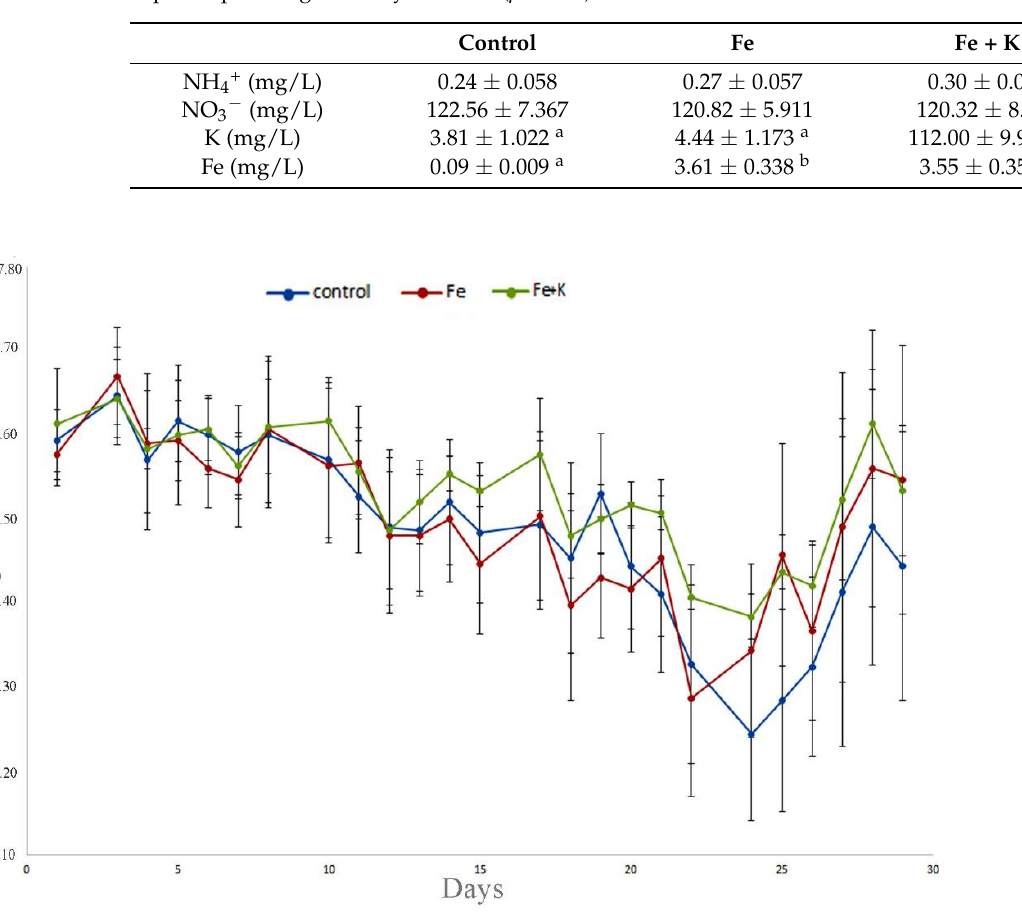
Figure 1. pH fluctuation in the various treatments during the experimental period. Data are expressed as mean ± S.E.M ( n = 3).